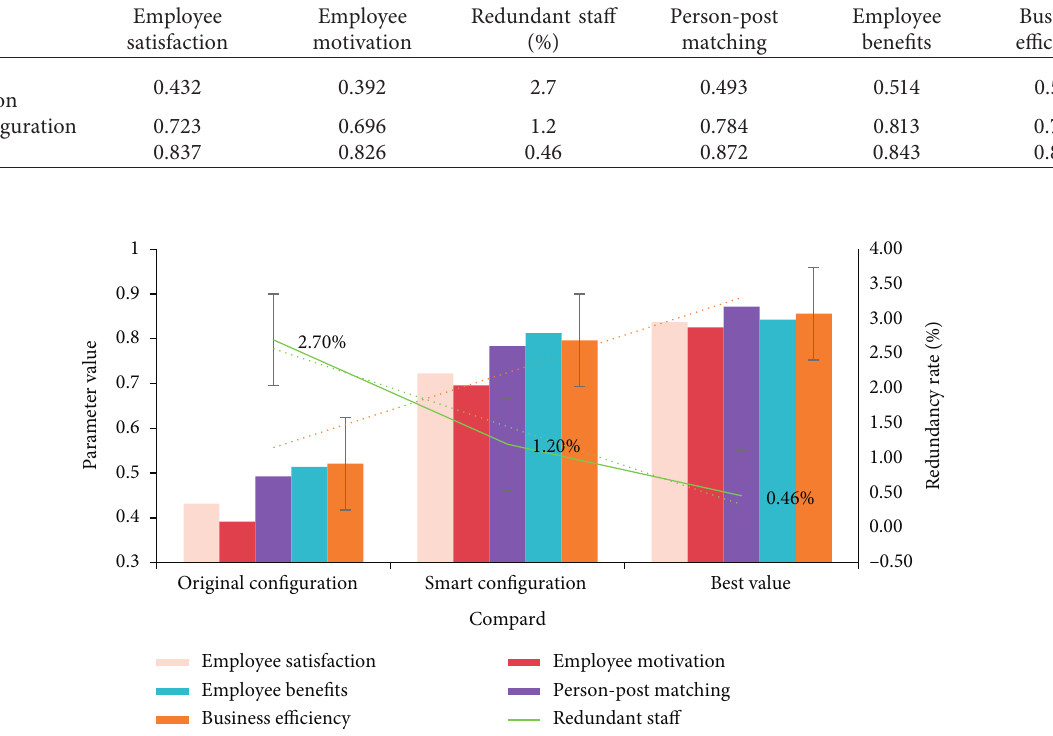
Figure 7: Optimized employee